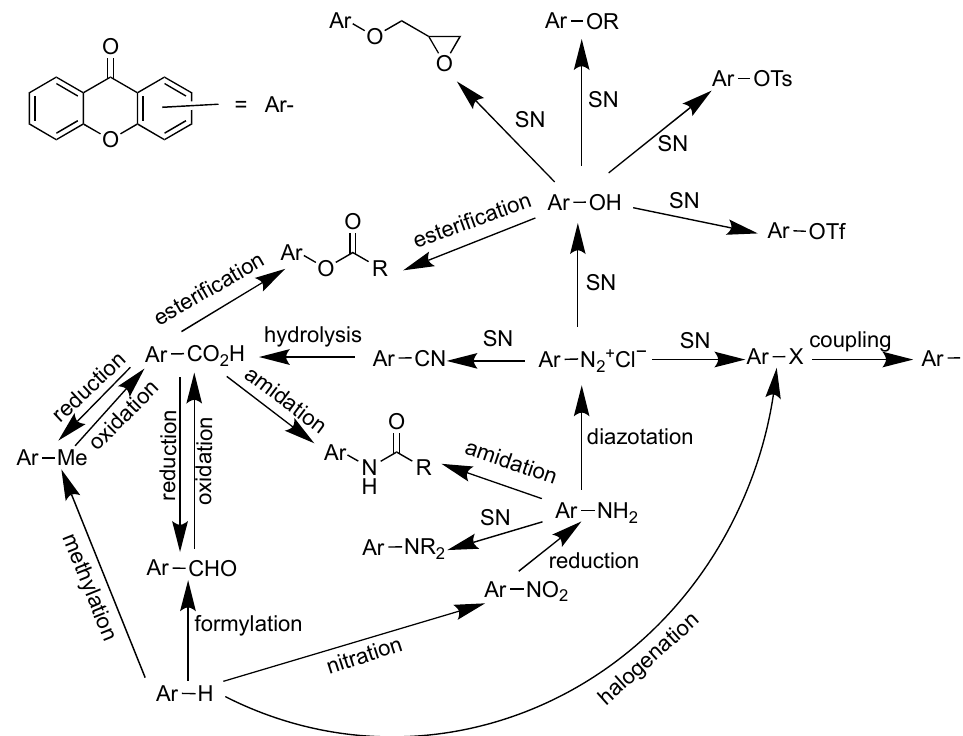
Figure 9. The functional groups’ interconversion of xanthone derivatives.